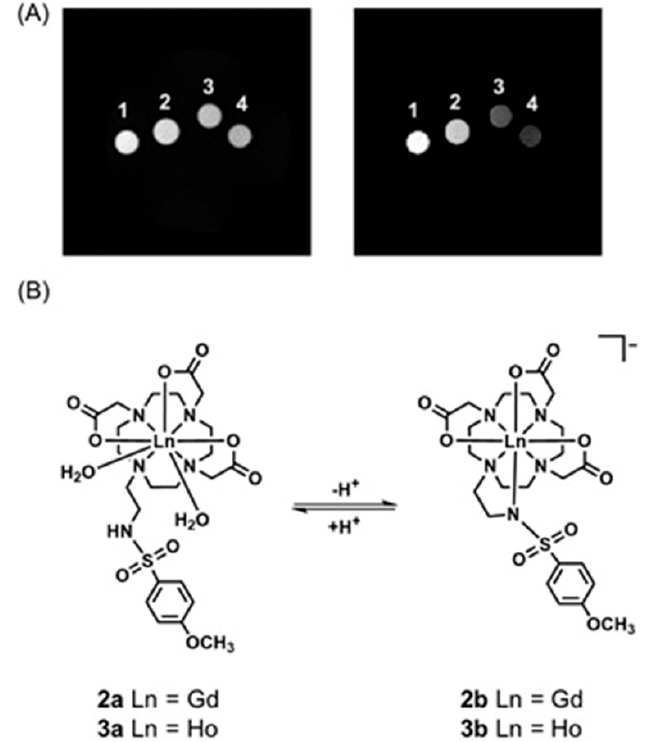
Figure 8. ( A ) MRI images of four samples at pH (1) 5.9, (2) 6.4, (3) 6.9, and (4) 7.4: (left) before normalization and (right) after normalization with respect to the Gd III concentration of the four samples determined via SPECT measurements. ( B ) Chemical structures of complexes 2 and 3 . Adapted with permission of the Royal Society of Chemistry, from Dual MRI-SPECT agent for pH-mapping, Gia- nolio, E.; Maciocco, L.; Imperio, D.; Giovenzana, G. B.; Simonelli, F.; Abbas, K.; Bisi, G.; Aime, S. 47 ,